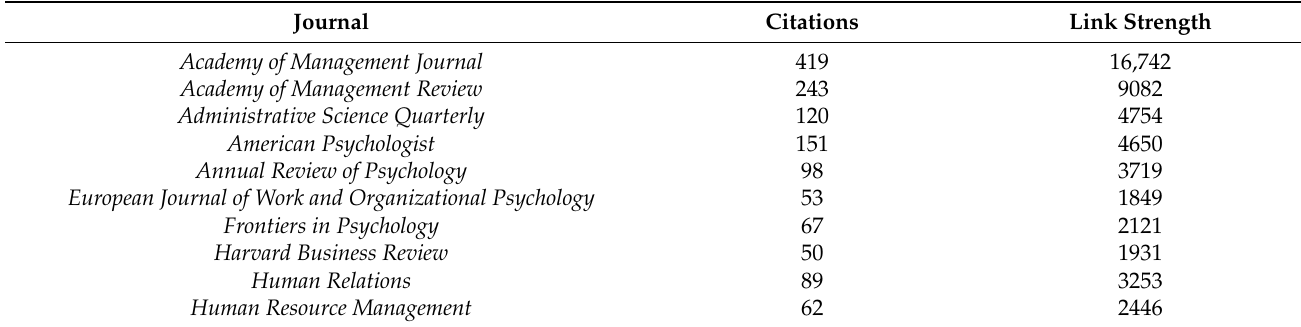
Table 6. Ten more influential journals in the topic of thriving at work in terms of co-citation and relation between them.